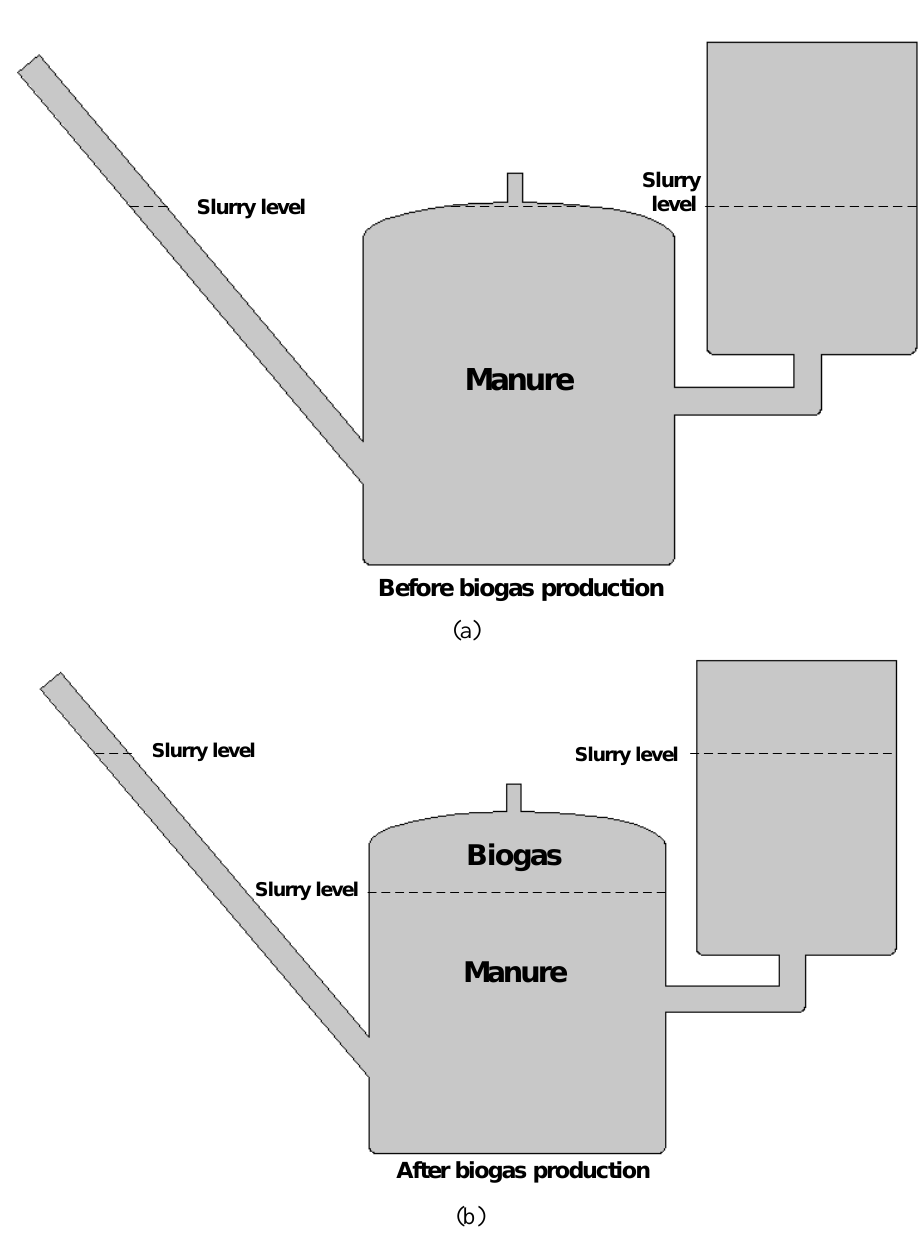
Figure 1. Schematics of the blank digester ( a ) before and ( b ) after gas production (Adapted from ref [25]).